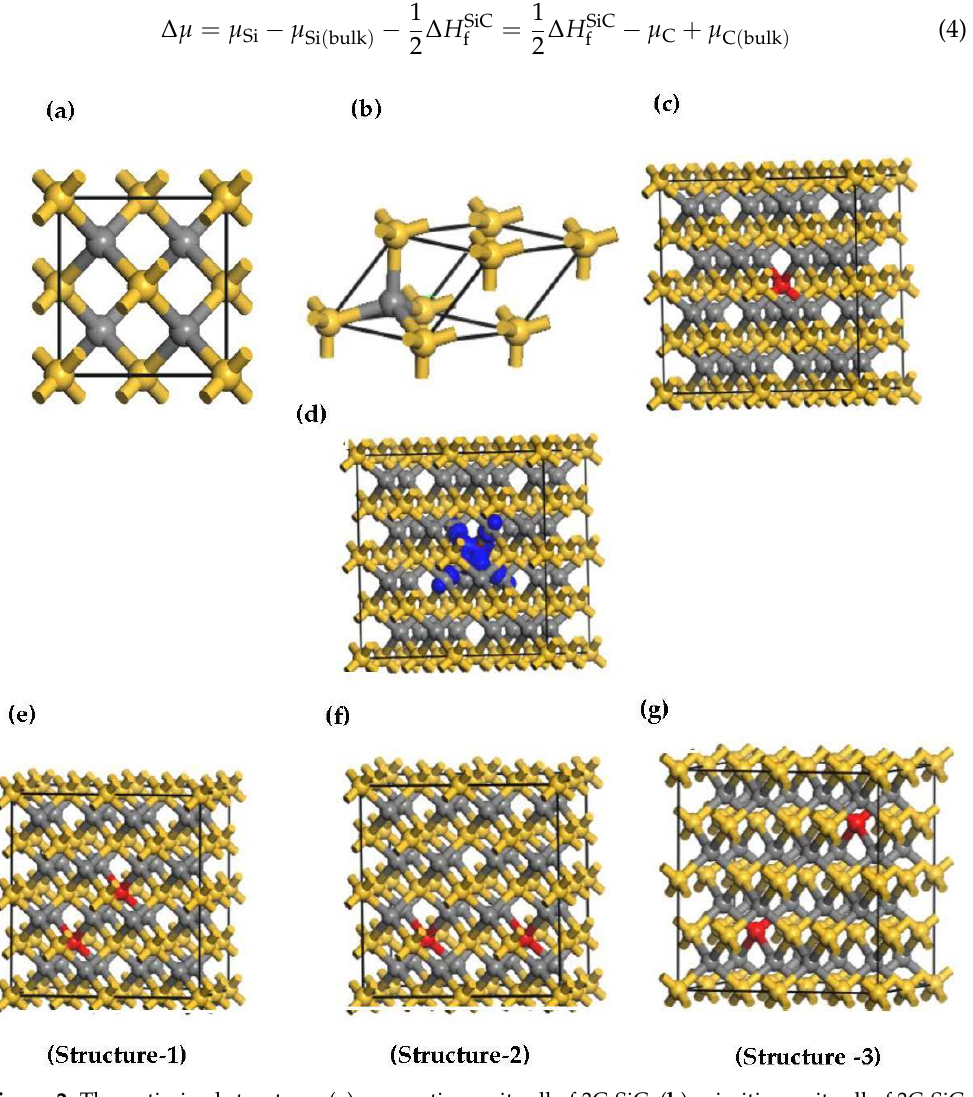
Figure 2. The optimized structures ( a ) convention unit cell of 3C-SiC, ( b ) primitive unit cell of 3C-SiC, ( c ) single (Mn +2 )-doped 3C-SiC, ( d ) the electronic density of spin diffusion of (Mn +2 )-doped 3C-SiC, ( e – g ). Three configurations of 2 atoms of (Mn +2 )-doped 3C-SiC. Yellow, silver, and red balls indicate Si, C and Mn +2 respectively. The blue is iso-surface of spin distribution of the Mn +2 dopant.